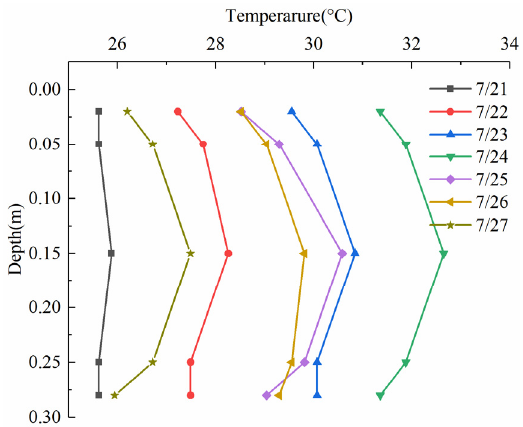
Figure 12. Initial temperature distributions at 6:00 for a week.